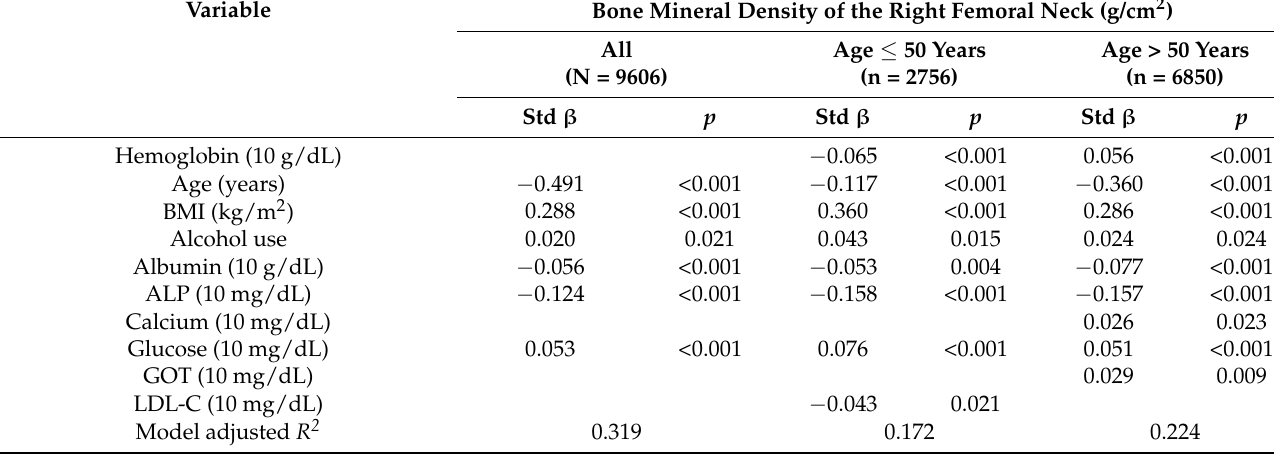
Table 7. Multiple linear regression analysis of factors associated with bone mineral density of the right femoral neck in female patients with and without stratification by age group. Variable Bone Mineral Density of the Right Femoral Neck (g/cm 2 )